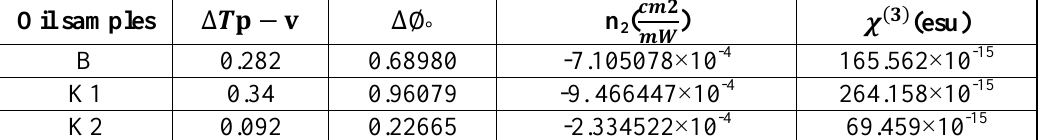
Table 5: The experimental results for the test samples in CA/CO